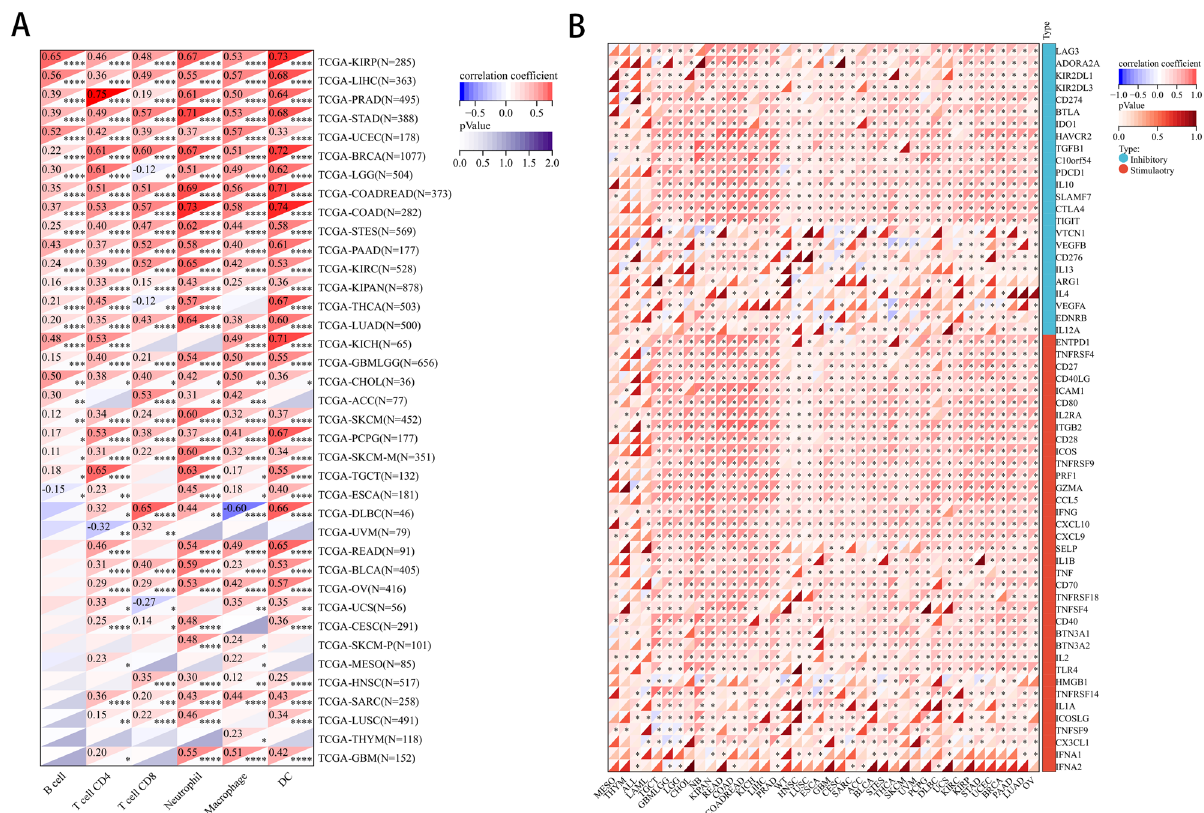
Figure 10. ( A ) Association of CLEC2B expression and immune cell infiltration using TIMER method. ( B ) The correlation between CLEC2B and immunoregulation-related